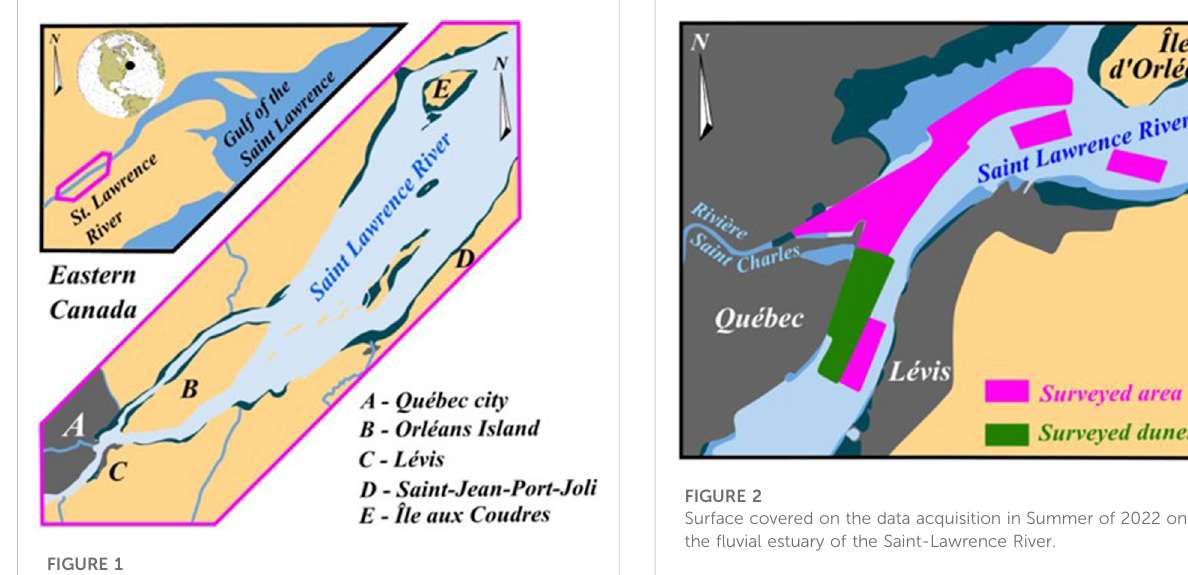
FIGURE 1 Studied area of the Saint Lawrence River estuary between Quebec City and Île aux Coudres.